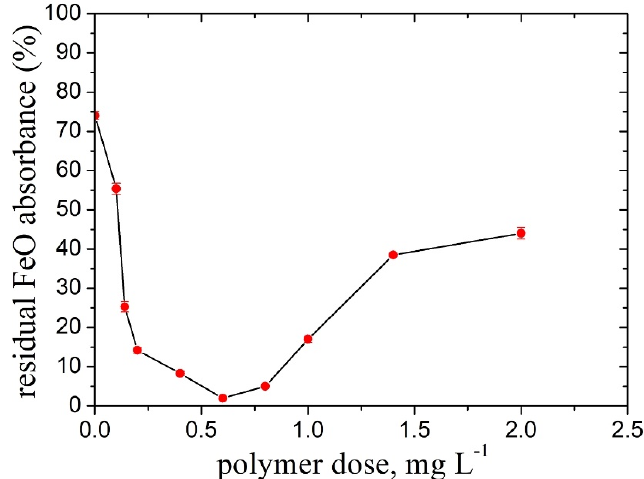
Figure 7. The residual FeO absorbance (%) dependence on the polymer dose ( TMAP 0.7 –P ) at pH 9.5, c FeO = 0.4 g L − 1 , c ip = 1 g L − 1 , settling time 120 min. c FeO = 0.4 g L − 1 , c ip = 1 g L − 1 , settling time 120